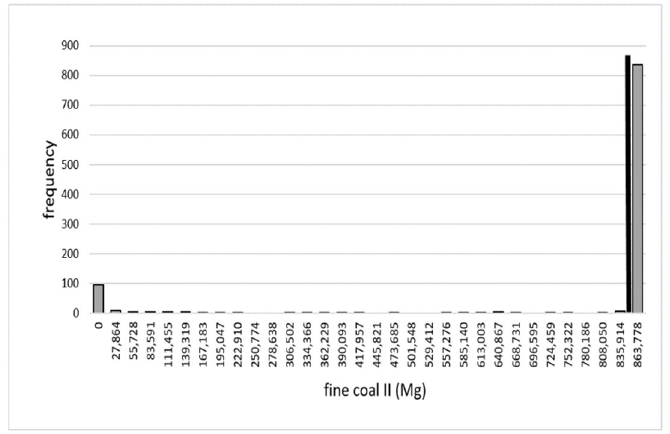
Figure A17. Histogram showing frequencies of achieving given quantity of sales of fine coal II for mine “E” with σ yprog .